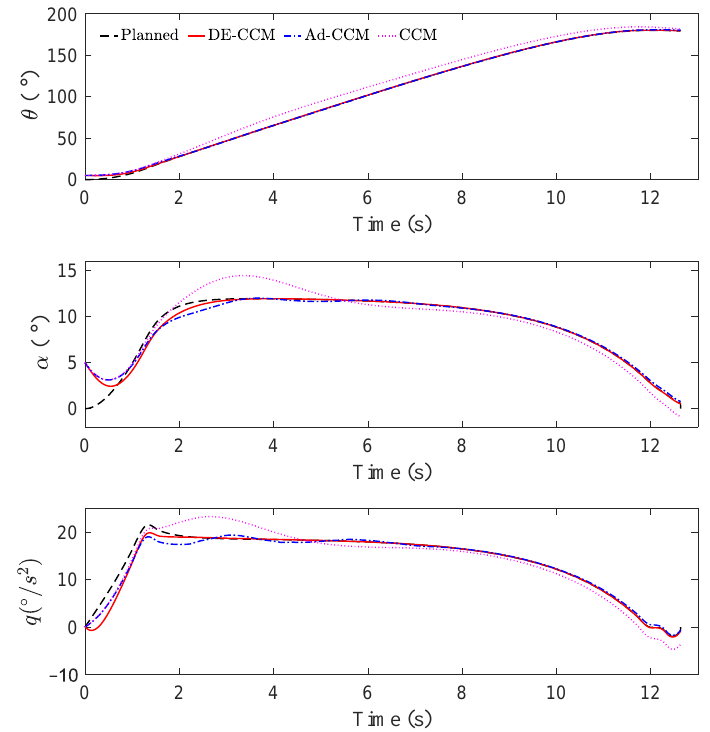
Figure 2. Trajectory tracking performance of different controllers.